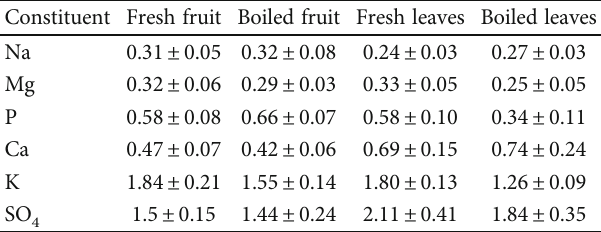
Table 2: Mean ± SE Concentration (%) of macro-mineral in Solanum